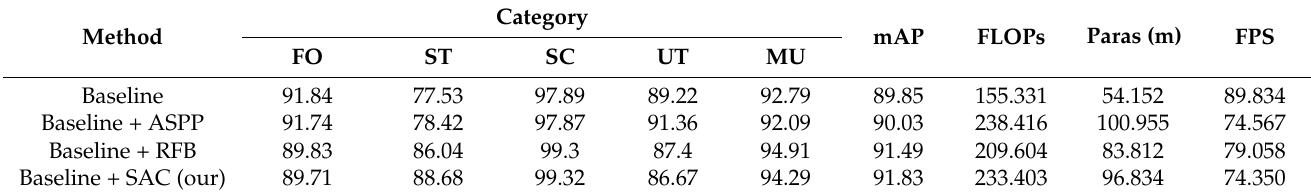
Table 4. Comparing with different receptive field